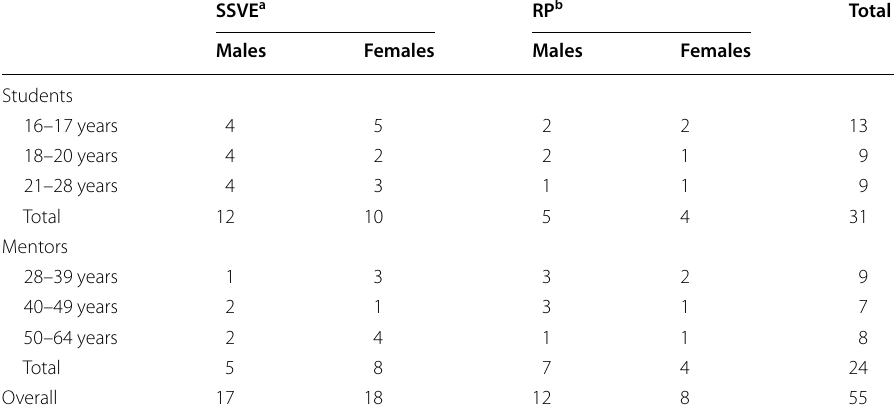
Table 1 Student and mentor participants’ program, gender, and